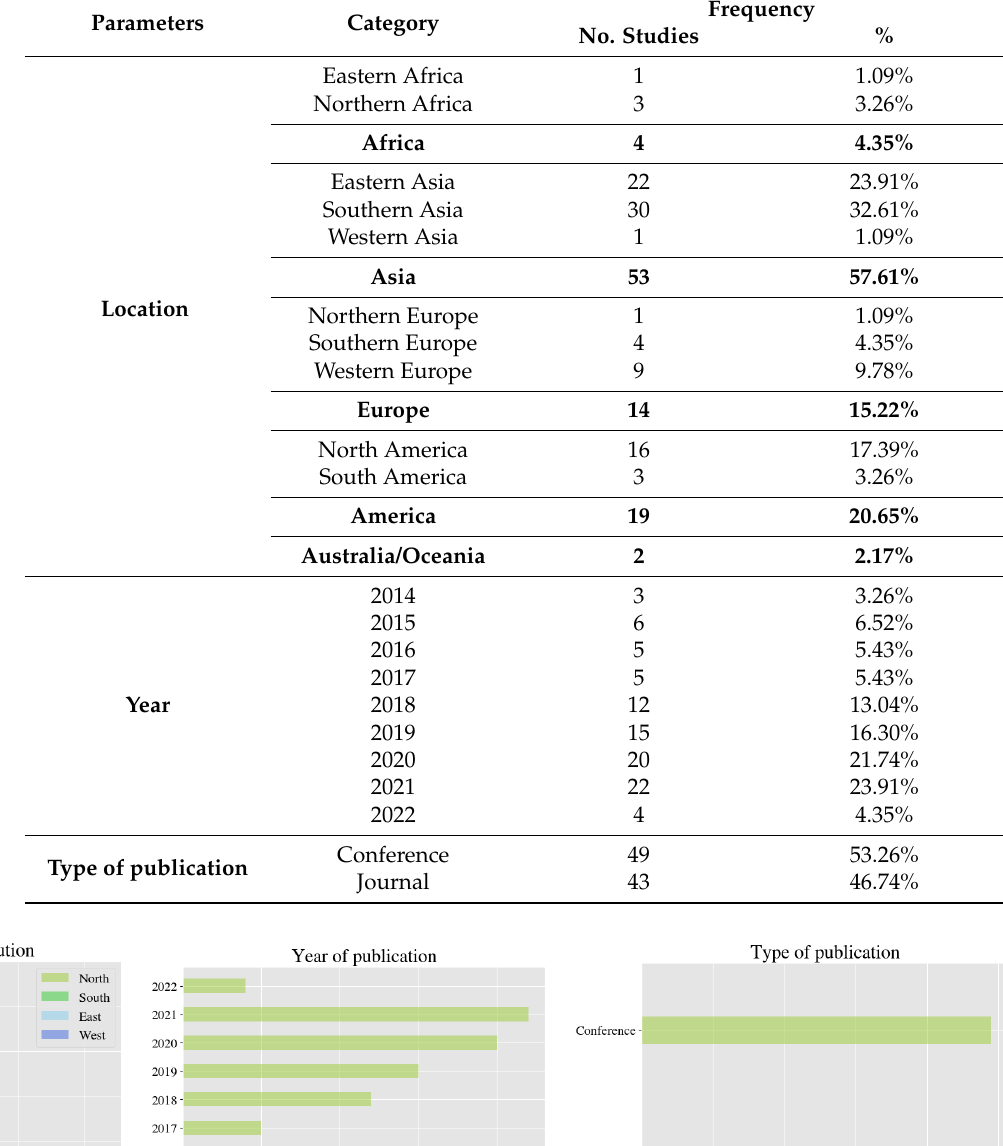
Table 4. Number and frequency of studies categorized according to geographical distribution, year, and type of publication following first eligibility stage.